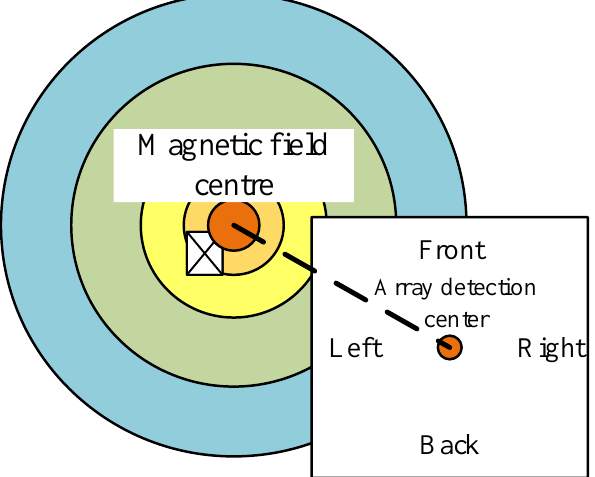
Figure 14. Array linear Hall element location diagram.